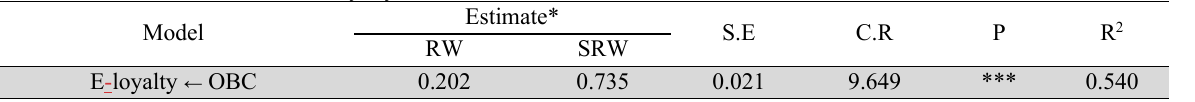
Estimation results of the OBC on